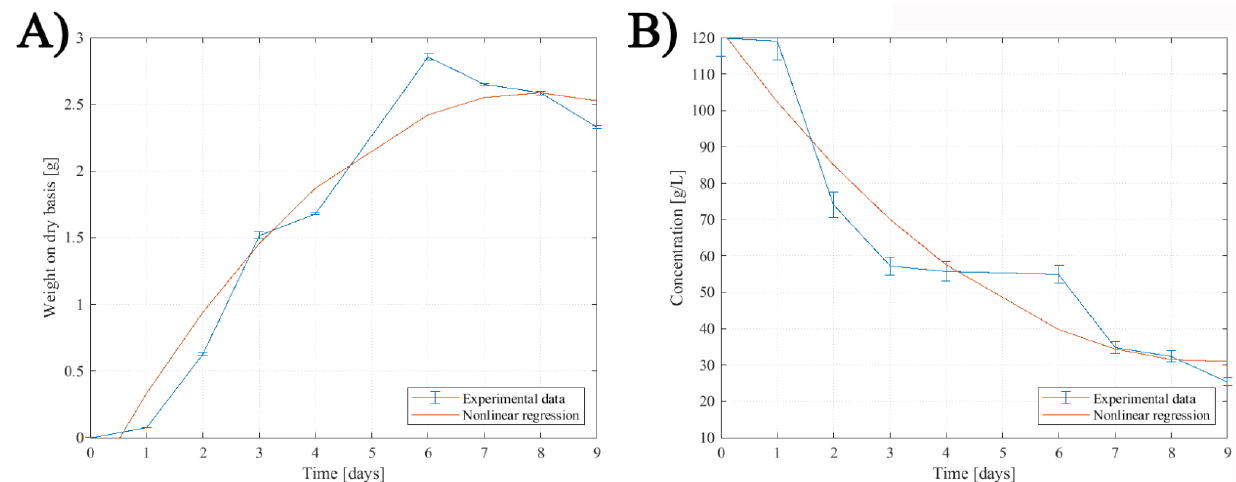
Figure 2. Fungus growth curve ( A ) and its carbon consumption ( B ).